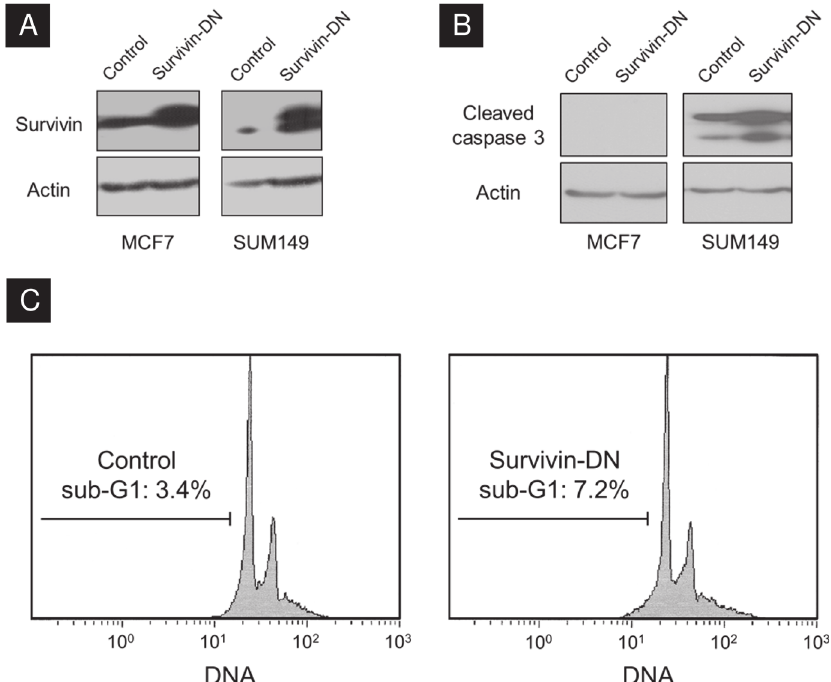
Fig 3. Cells transduced with the survivin dominant-negative construct display higher levels of apoptotic markers. A) MCF7 and SUM149 breast cancer cell lines were successfully transduced with the survivin dominant-negative construct, as shown by Western blot. B) Survivin-DN cells display greater levels of cleaved caspase 3 compared to the control; MCF7 shows no expression of caspase 3, consistent with the literature [32]. C) Survivin-DN cells have a greater fraction of sub-G1 (i.e. apoptotic) cells compared to the control, when stained with Propidium